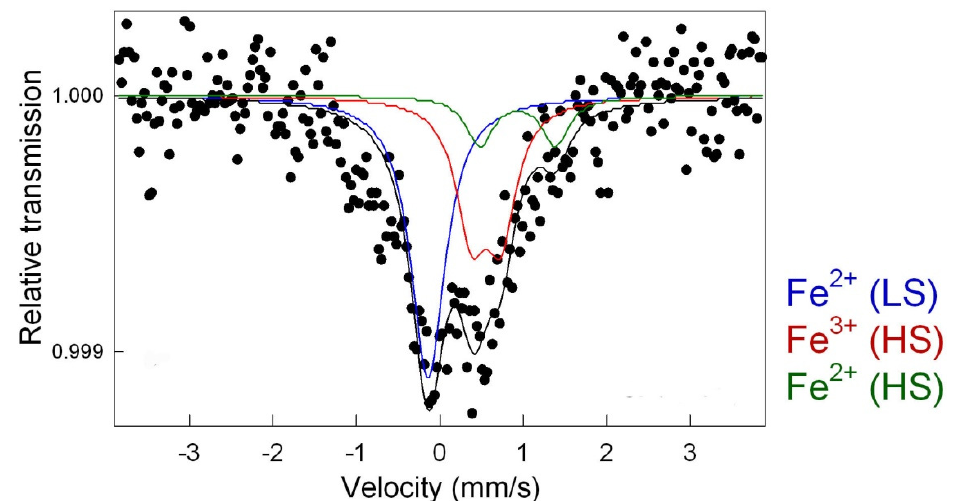
Figure 5. Room-temperature Mössbauer spectra of sample CFeN@rGO-COOH. The existence of iron can endow a catalyst with paramagnetic properties. The mag- netization hysteresis curves of the annealed catalyst under an appropriate magnetic field range at room temperature were measured to check its magnetic characteristics. The tested catalyst exhibited standard ferromagnetic hysteresis loops due to the presence of metallic iron nanoparticles (Figure 6). The saturation magnetization of CFeN@rGO- COOH was determined to be 7.5 emu g − 1 , which is lower than pristine iron whose satura- tion magnetization can reach 220 emu g − 1 [55]. The lower saturation magnetization value of the annealed catalyst may indicate less metallic iron [56]. The magnetic properties of the annealed catalyst (CFeN@rGO-COOH) were connected with its catalytic activity and ability to increase oxygen transportation. Figure 6. Magnetic hysteresis loops of the CFeN@rGO-COOH sample. 3.2. Electroreduction of Oxygen and Diagnosis Measurements The cyclic voltametric (CV) curve of CFeN@rGO-COOH catalyst in a deoxygenated electrolyte is shown in Figure 7, which exhibits mainly a rectangular shape with high background current density, is a typical attribute of carbonaceous materials. Furthermore, a small and poorly defined reduction peak appeared in the potential range of 0.7–0.8 V. The catalytic materials in the presence of an external magnetic field showed slightly